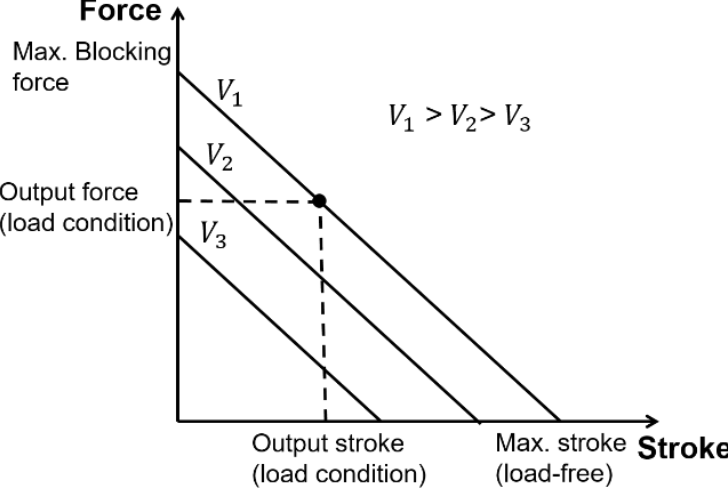
Figure 4. Force–stroke characteristic of the piezoelectric stack.